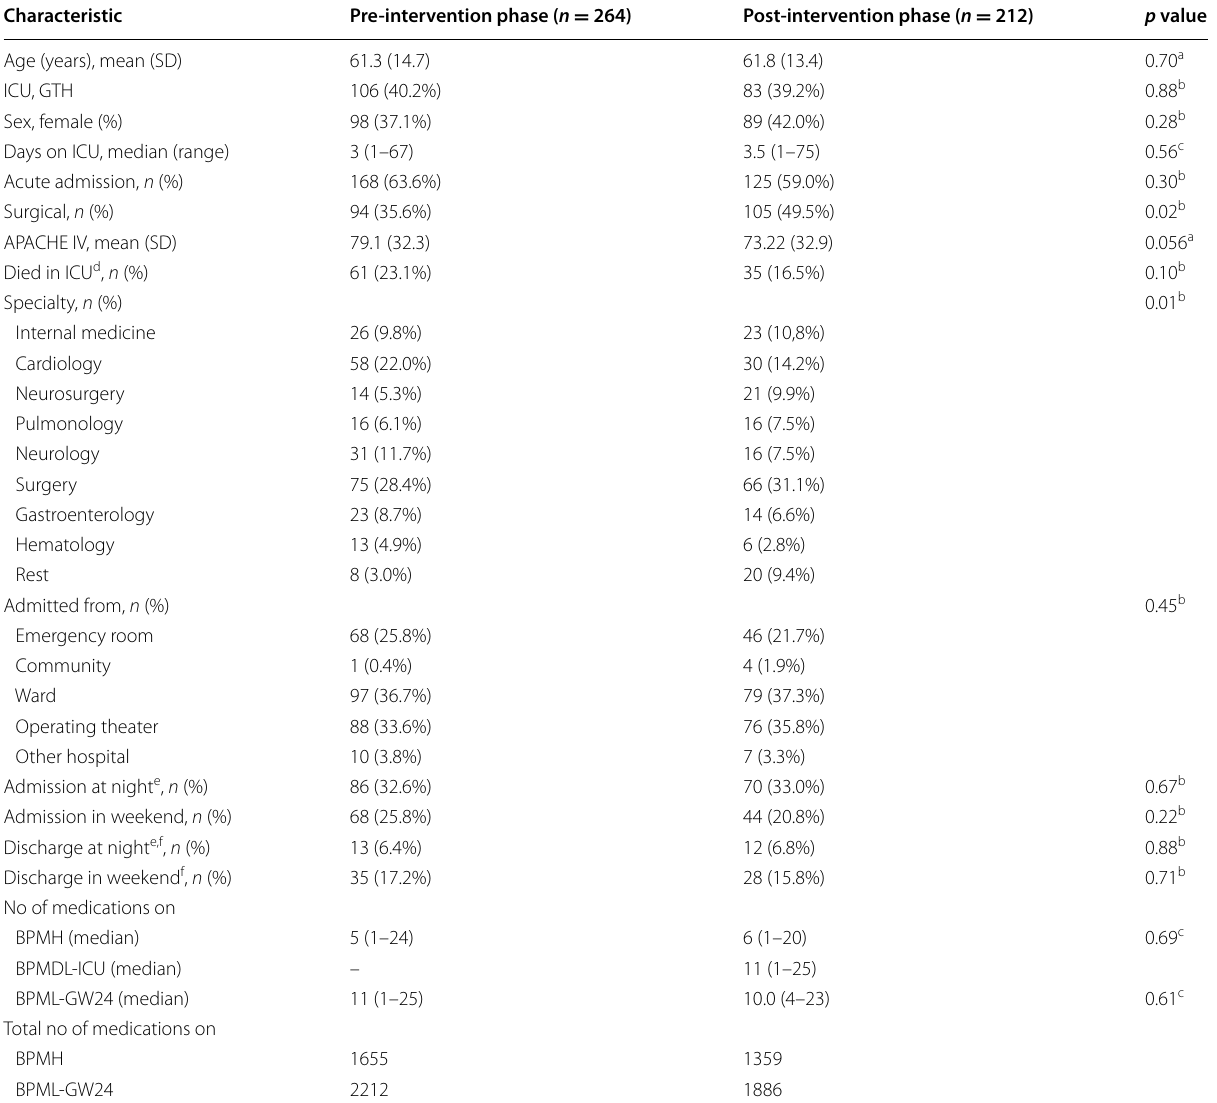
Table 1 Patient